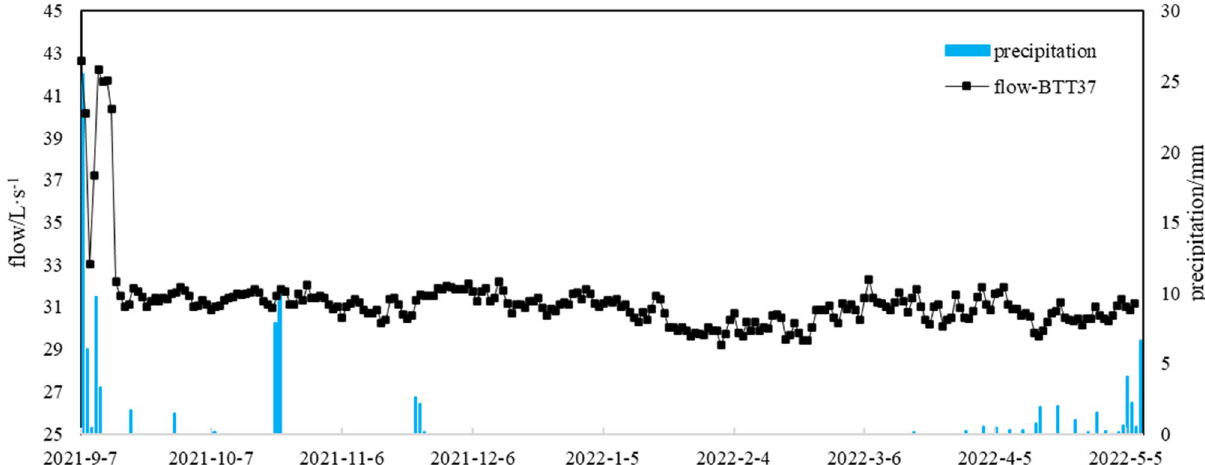
Figure 4. Precipitation (measured at the Batang meteorological station, data from http:// data. cma. cn/)) and flow of BTT37 from September 7, 2021 to May 5,